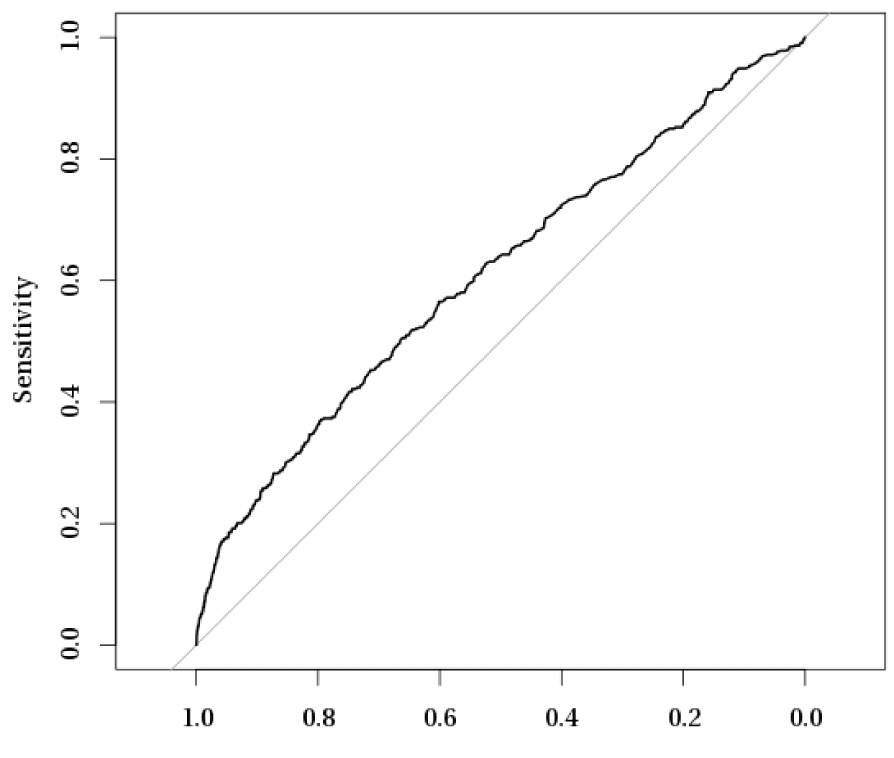
Figure 3. Receiver operating characteristic (ROC) curve analysis of sensitivity / specificity evaluation of multiple logistic regression model for chronic postoperative